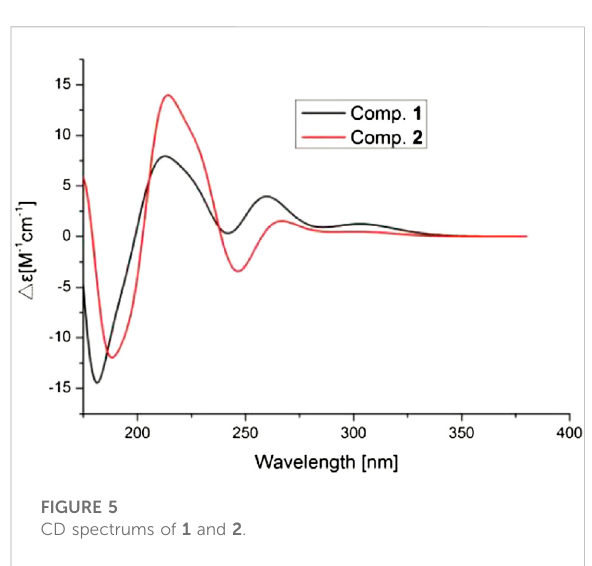
FIGURE 5 CD spectrums of 1 and 2